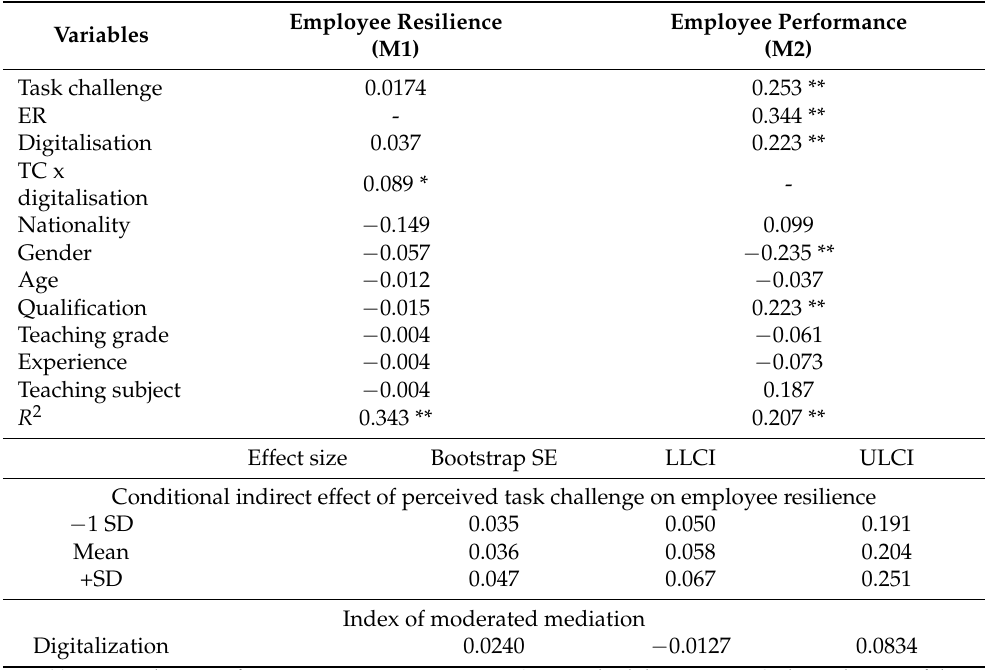
Table 6. Moderated-mediation analysis (Process Macro Model